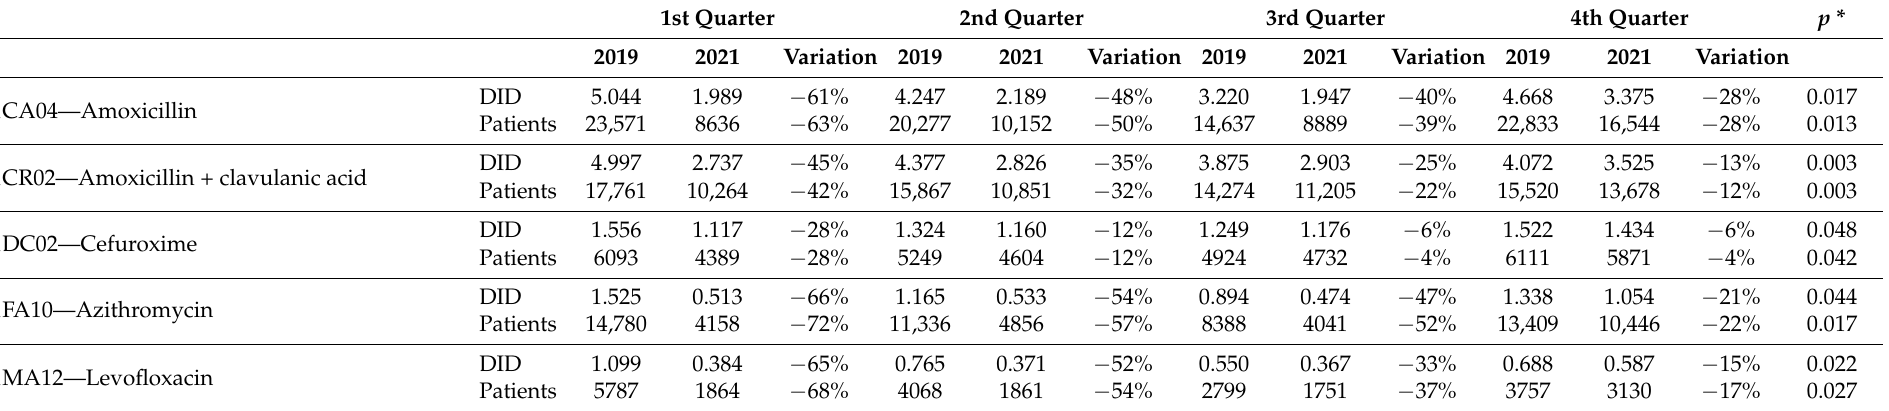
Table 2. Evolution of the consumption of considered strategic antibacterials for respiratory tract infections in the community in Navarre per quarters (DID and patients